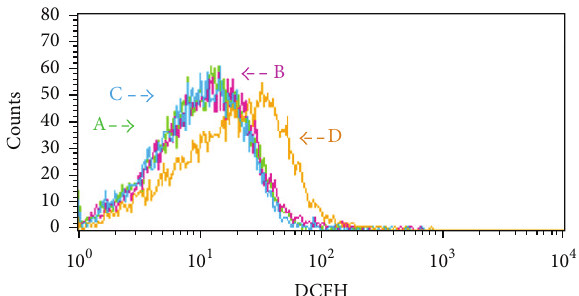
Figure 5: Reactive oxygen species (ROS) in E. coli cells were analyzed using flow cytometry with DCFH-DA staining after treatment of hypocrellin B (25 𝜇 M) and blue light irradiation (12J/cm 2 ). A: sham control; B: hypocrellin B treatment alone; C: blue light irradiation alone; and D: photodynamic treatment of hypocrellin